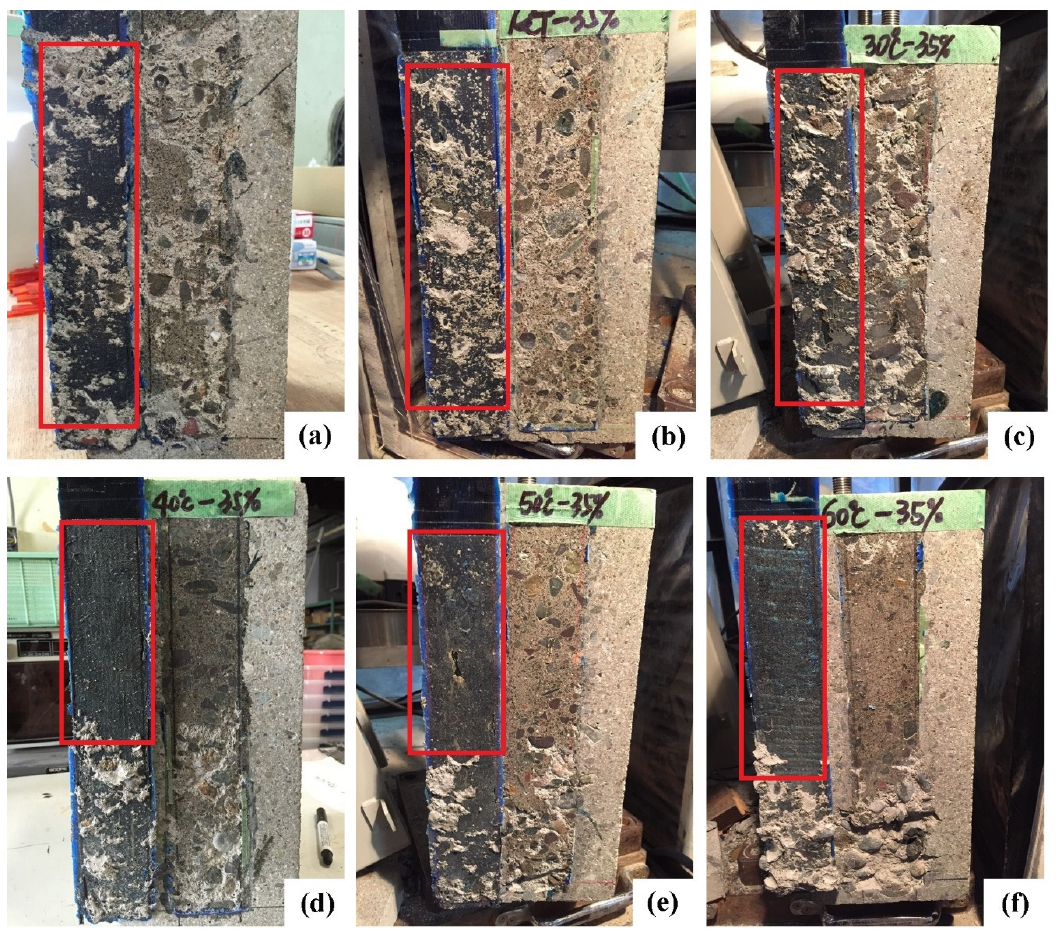
Figure 3. Comparison of failure surfaces at various exposure conditions: ( a ) control; ( b ) 15 °C; ( c ) 30 °C; ( d ) 40 °C; ( e ) 50 °C; ( f ) 60 °C.